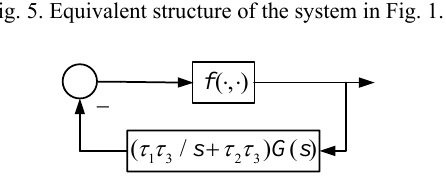
Fig. 6. Standard Lur’e form of the system in Fig.